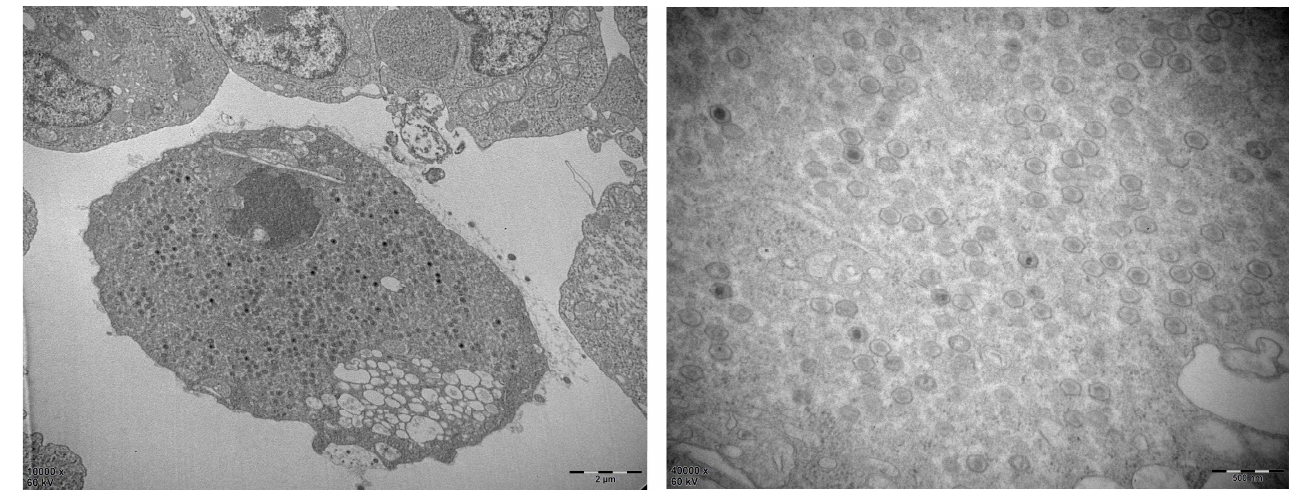
Figure 1. Viral particles examined using electron